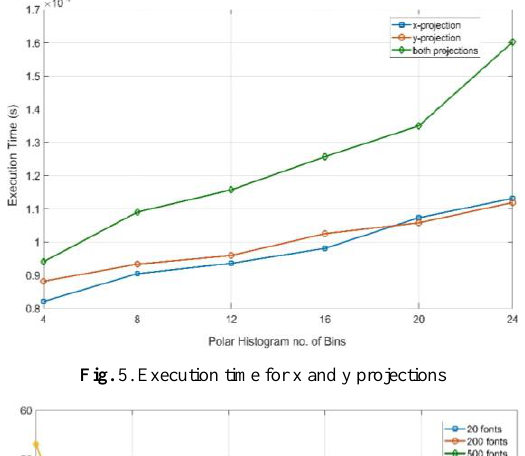
Fig. 5. Execution time for x and y projections